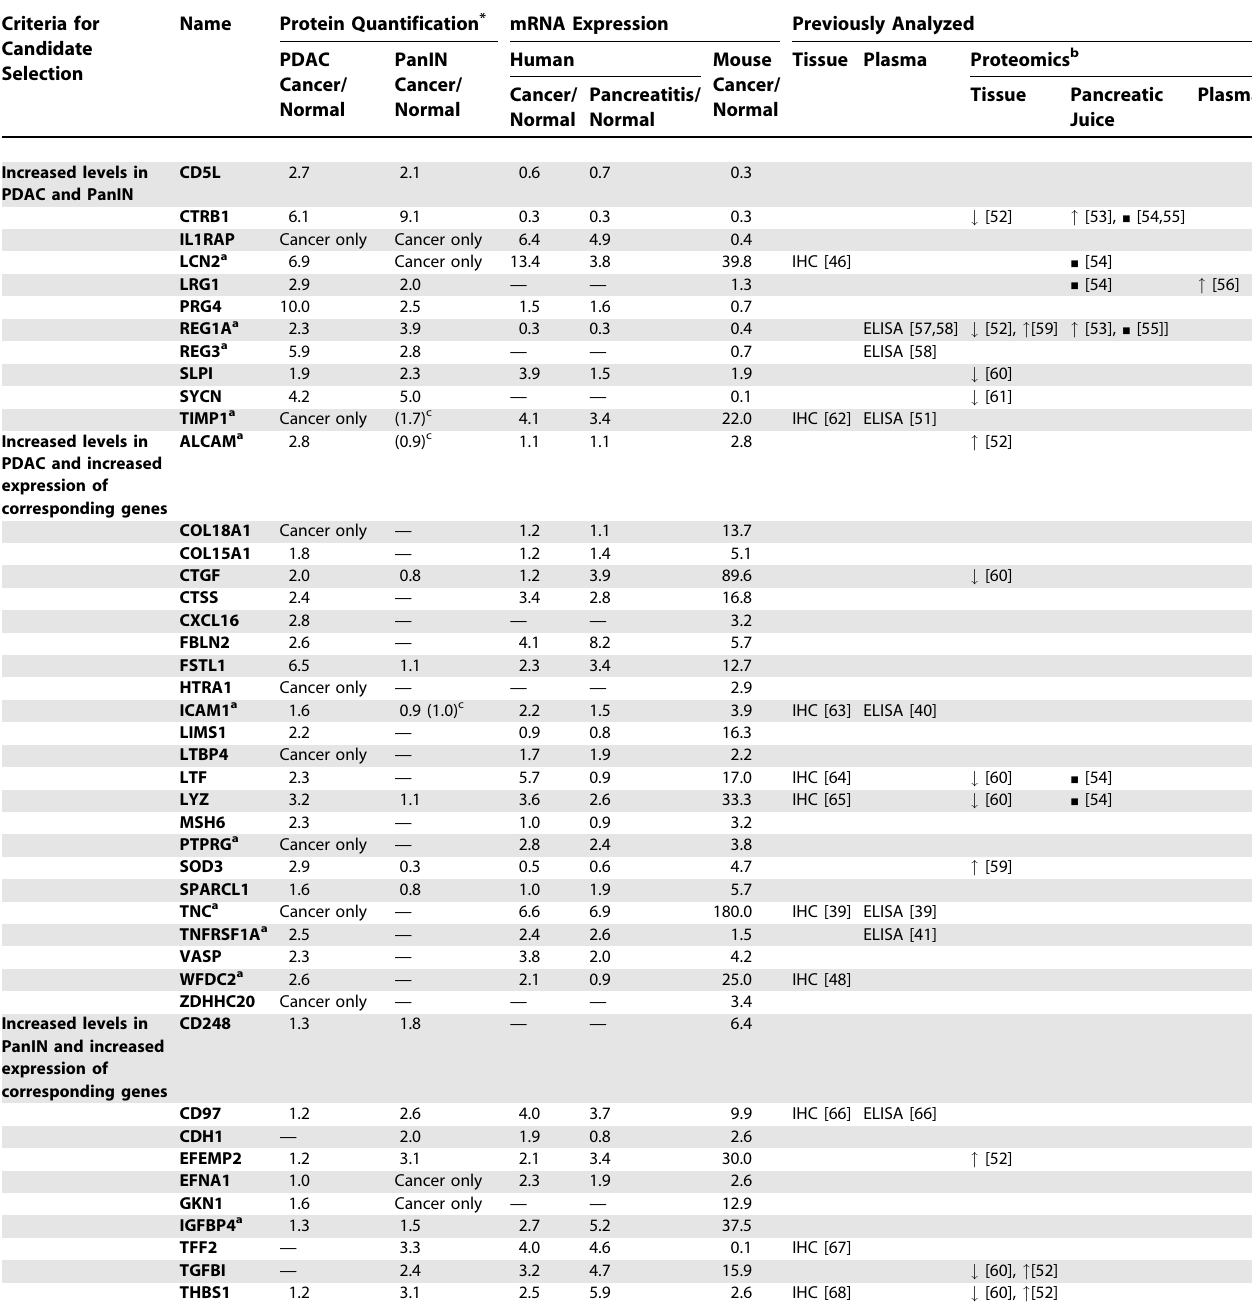
Table 1. Proteins Potentially Relevant to Pancreatic Cancer Revealed by the Proteomic Analysis of Mouse Model Plasma Criteria for